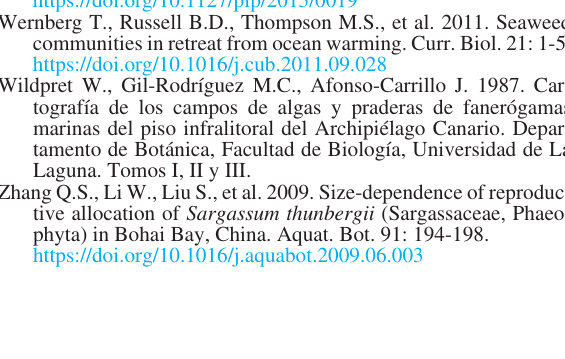
Fig. S1. – Cystoseira abies-marina communities in the 1980s, including those from Wildpret et al. (1987) (A) and from oral Table S2. – Types of human pressures, Corine Land Cover (CLC) codes, area and length percentages, and corresponding scores used in calculations of the HAPI index in coastal sectors and populations of Gran Canaria Island. Table S3. – Percentages of the area and length of each sector ac- cording to human pressure. Pressure scores (PS) assigned to each pressure are indicated. Correlation coefficients (R 2 ) between pressures, turnover score (TS) and the HAPI